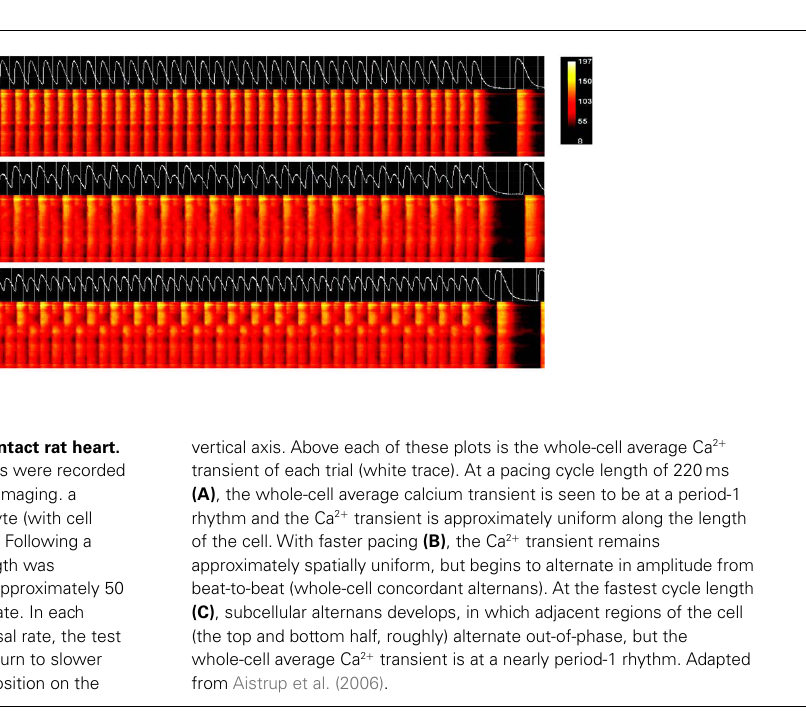
distance on the vertical axis. (A) Although during control conditions (line-scan images a–b ) the Ca 2 + transient is nearly homogeneous, application of tetracaine causes a marked subcellular alternans pattern (shown in line-scan images c–g ). Note the mini Ca 2 + -wave seen to propagate away from the dashed line in e . (B) A propagating Ca 2 + -wave is seen to initiate from an area of steep gradient in Ca 2 + concentration (obtained in tetracaine). Adapted from Díaz et al. (2002).